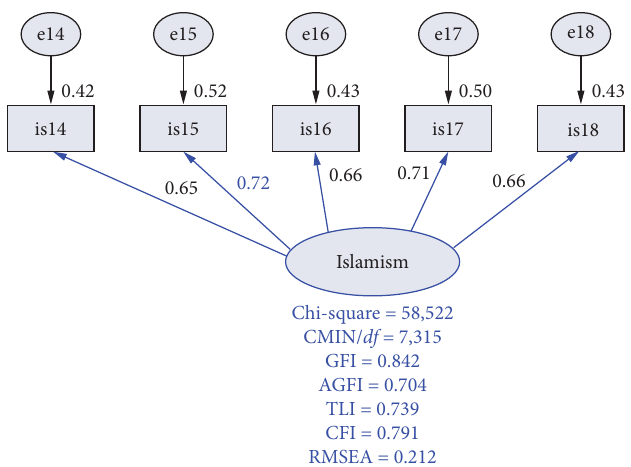
F IGURE 4: Diagram and output of AMOS 24 application for Islamism